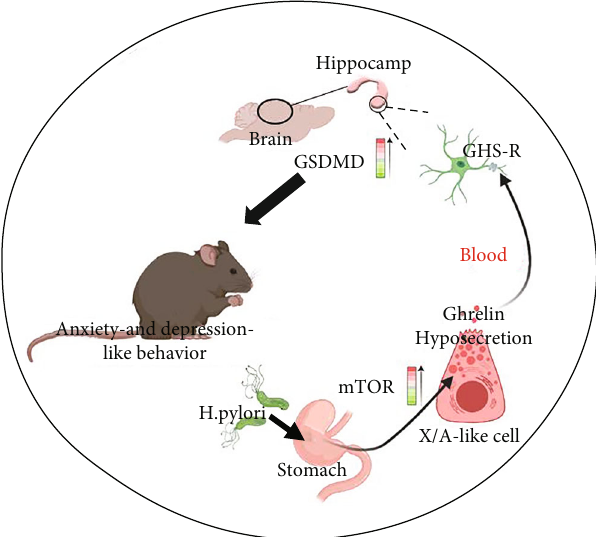
Figure 6: Schematic overview of H. pylori causes anxiety and depression-like behavior by ghrelin